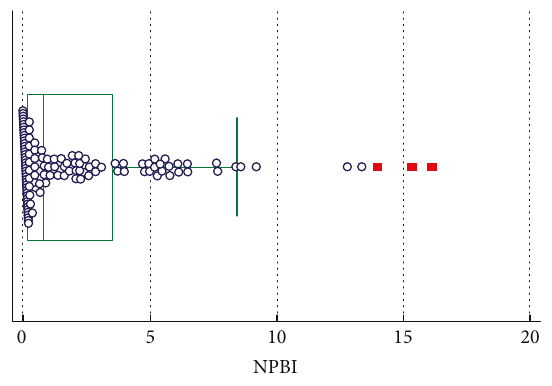
Figure 2: Box and whisker plot for NPBI.